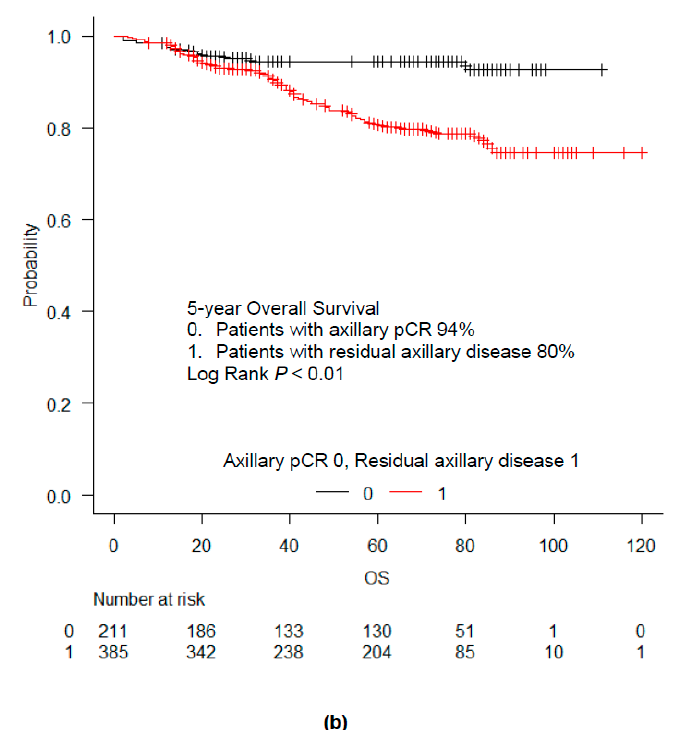
Figure 2. Survival outcomes according to pathological LN response to NAC. Kaplan–Meier curves for distant disease-free survival (DDFS) ( a ) and overall survival (OS) ( b ) in all patients with cytologically proven node-positive breast cancer after NAC. The 5-year DDFS and OS rates were 90% and 94%, respectively, in patients with axillary pCR; 70% and 80%, respectively, in patients with residual axillary disease ( p < 0.01 for both DDFS and OS). DDFS—distant disease-free survival, NAC—neoadjuvant chemotherapy, OS—overall survival, pCR—pathological complete response. Table 2. Multivariate analysis of prognostic factors related to DDFS in patients with NAC.